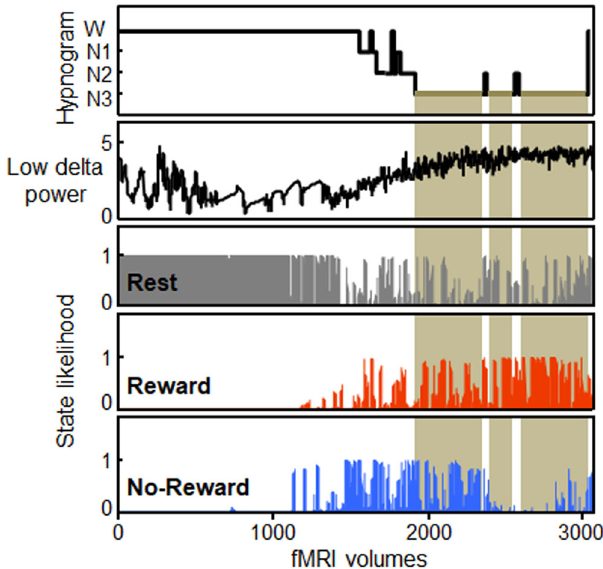
Fig. 2 Data from one representative participant. From top to bottom: Hypnogram, time course of the log-transformed power values for low delta (1 – 2 Hz), time-courses of likelihood for the Rest (in gray), Reward (in red), and No-Reward (in blue) brain states (pre-R and pre-NR are not represented here). Periods of N3 are highlighted in light brown. Increased likelihood of the brain state corresponding to the rewarded game is visible during N3. W indicates Wake; N1, N2, N3 indicate N1, N2, N3 sleep stages pre-reward (pre-R) and pre-no-reward (pre-NR), corresponding to the 3 s preceding each game; see Supplementary Information. dated using a leave-one-out procedure with the data from the game session (Supplementary Fig. 1). We then applied this clas- si fi er to the data from the sleep session, which provided, for each